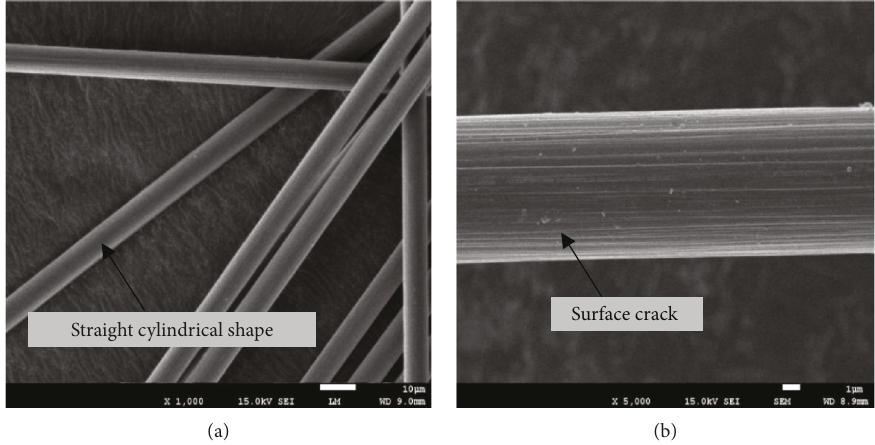
Figure 2: Form of carbon fiber. (a) Overall morphology at 1000 times. (b) Local morphology at 5000 times.